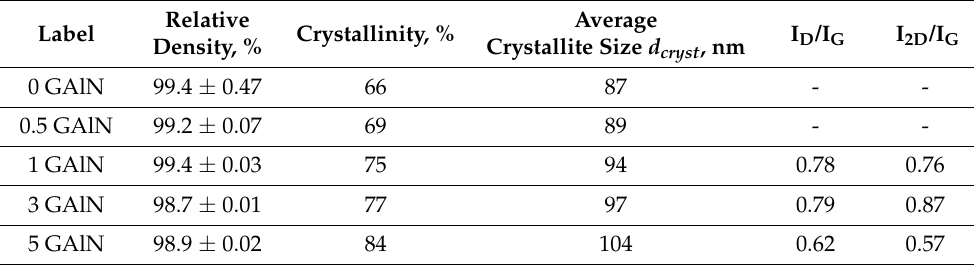
Figure 3. XRD patterns for ( a ) 0 GAlN and ( b ) 5 GAlN composites before and after polishing. Composites SPS-ed under chosen conditions is fully dense with relative density values of 98.7–99.4% (see Table 2). The introduction of GAlN has almost no effect on the density of composites. A different picture is observed when it comes to crystallinity (the ratio of crystalline to amorphous phase) of the samples. Nanosized zirconia-based precursor after annealing at 1073 K has a crystallinity value of ~30%, which is typical for oxide powders obtained via the sol-gel coprecipitation technique [40]. A broadening of the peaks is observed in XRD patterns of composites indicating that the crystalline structure is not formed completely. Indeed, the crystallinity value of the SPS-ed 0 GAlN reference sample is 66%, which is in good correlation with short dwelling time. The addition of 0.5–5 wt.% GAlN causes a close-to-linear increase of crystallinity up to 84% accompanied by the peaks narrowing in the corresponding XRD patterns. The sizes of crystallites estimated according to Equation (1) for single-phased polished samples change in accordance with crystallinity degree upon the increase of GAlN content and vary from 87 to 104 nm Table 2. Relative density, crystallinity, crystallite size and I D /I G, and I 2D /I G intensity ratios of GAlN/YSZ